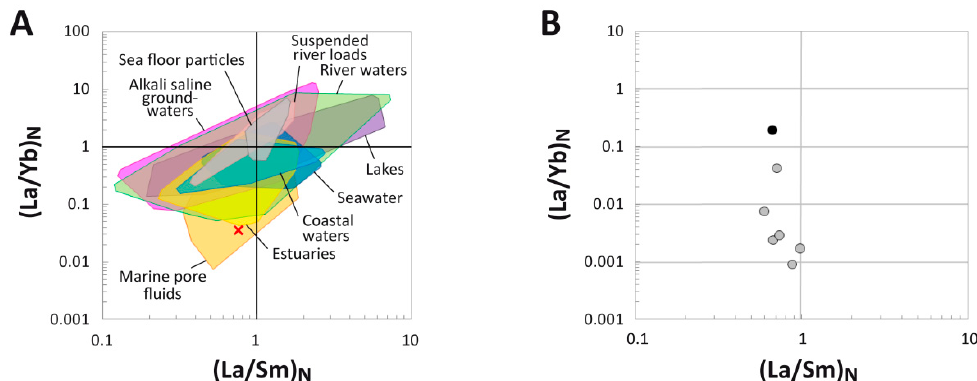
Figure 7. (La/Yb) N and (La/Sm) N ratios of the femur of MOR 1125. ( A ) Comparison of the whole-bone average (La/Yb) N and (La/Sm) N ratios of the fossil to ratios from various environmental waters and sedimentary particulates. Literature sources for environmental samples are provided in the Supplementary Materials. ( B ) REE compositions of individual laser transects expressed as NASC-normalized (La/Yb) N and (La/Sm) N ratios. The transect including the external bone margin is denoted by the black symbol, whereas all other (internal) transects are represented by gray sym- bols.